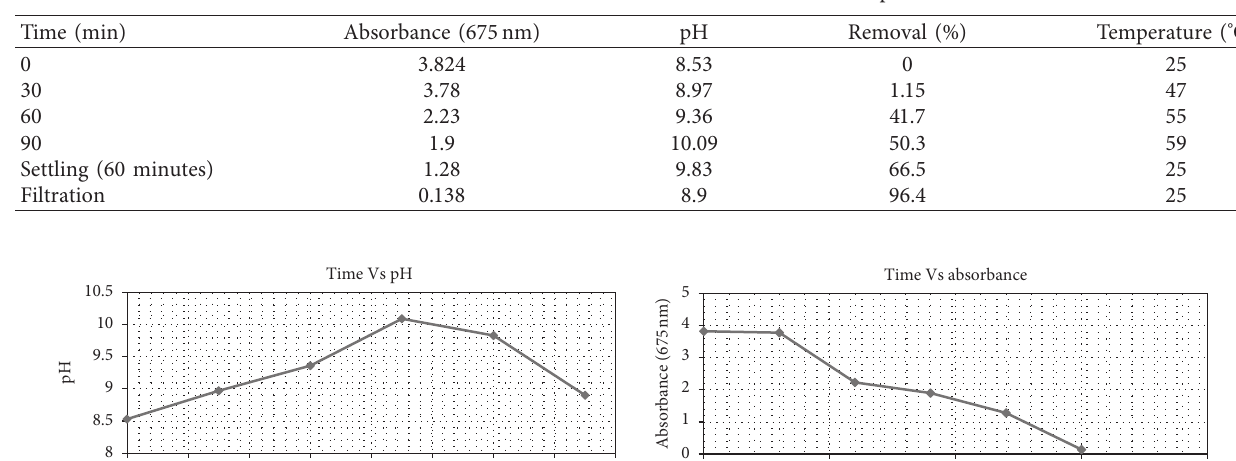
Table 4: Different characteristic values of collected sample.